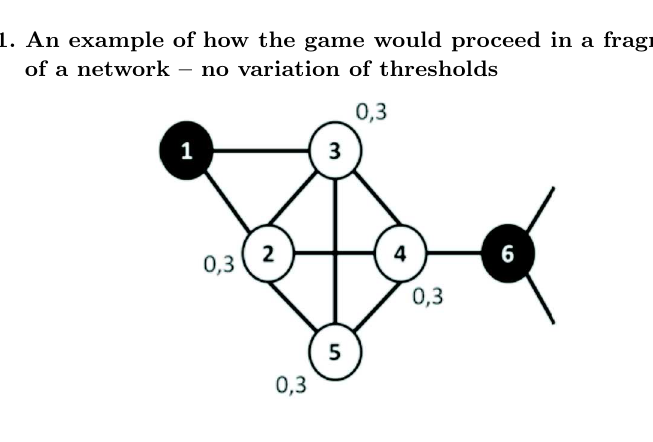
Figure 2. An example of how the game would proceed in a fragment of a network – different